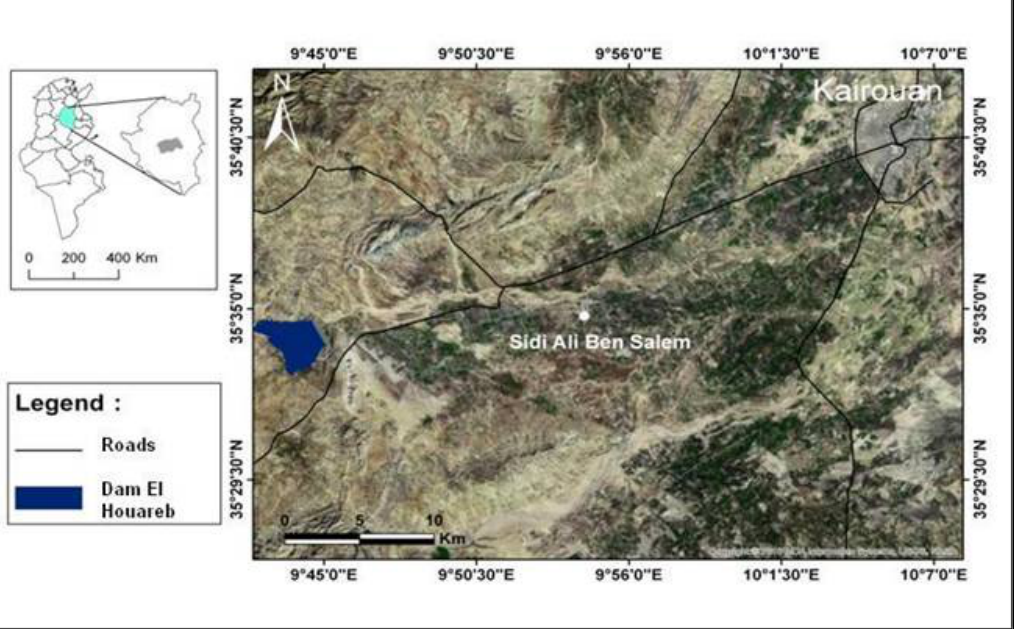
Figure 1. Illustration of the studied site.